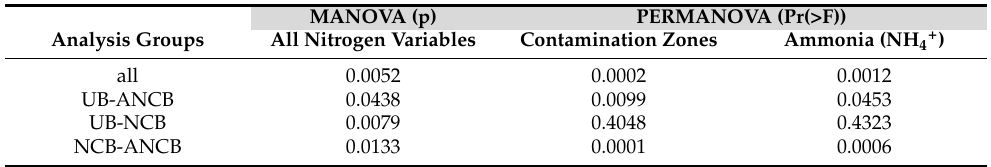
Table 2. P and Pr (>F) values from MANOVA and PERMANOVA statistical tests determining the differences between all data and pairwise analysis of the 3 contamination zones.